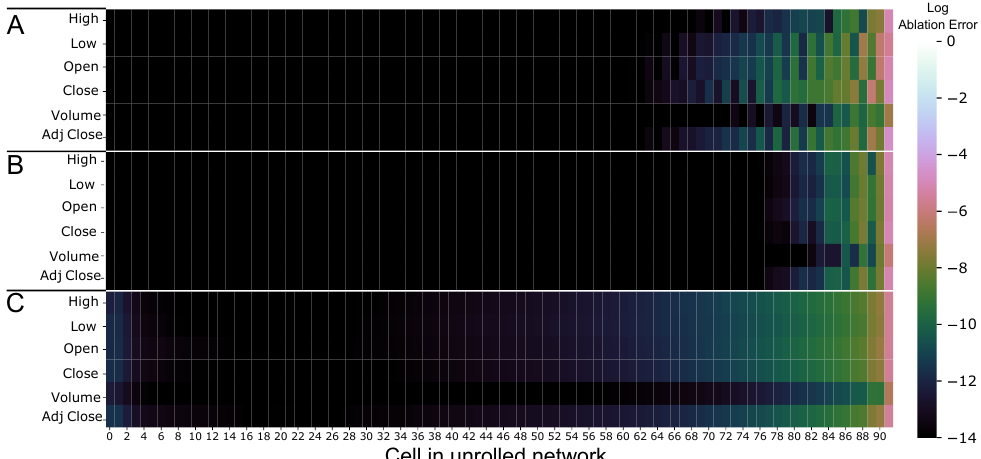
Figure 4. The log percentage SMAPE difference between the ablated prediction and reference prediction in ( A ) RNN, ( B ) LSTM, and ( C ) GRU neural